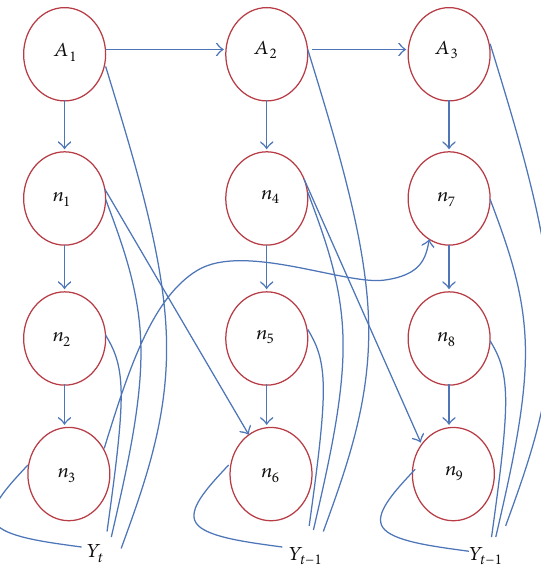
Figure 2: Markov model of Bayesian